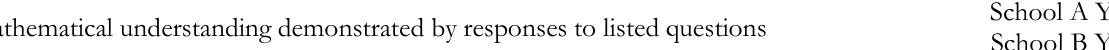
Table 1. Summary of Responses from Schools A and B Mathematical understanding demonstrated by responses to listed